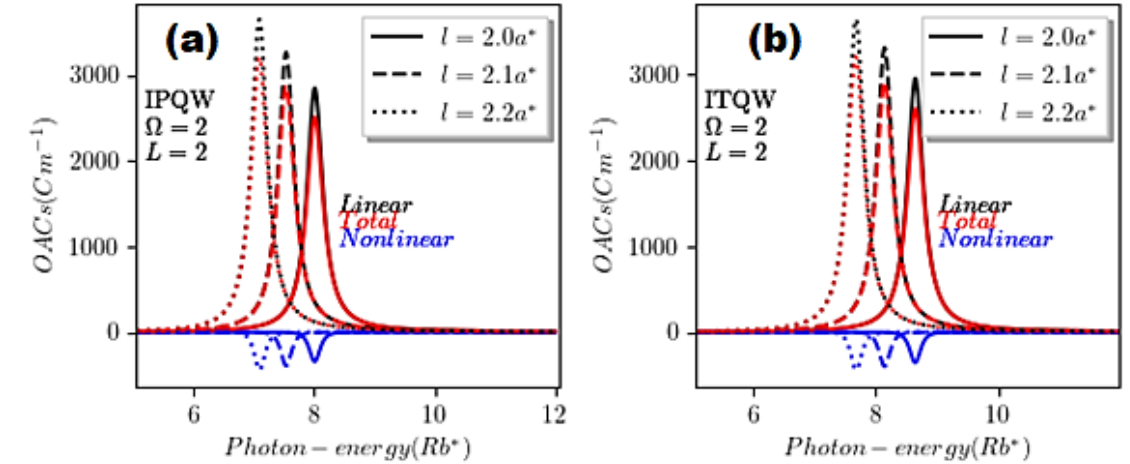
Figure 8: The OACs change versus incident photon energy (R*) with fixed barriers widths (L=2) and x =0.2 (Ω=2) at room temperature (T==300K) for three different values of the well width max